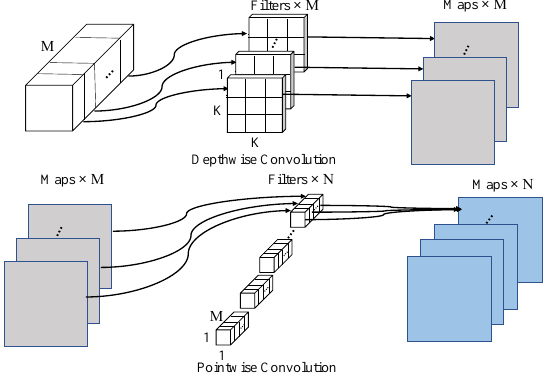
Figure 2. The structure of depthwise separable